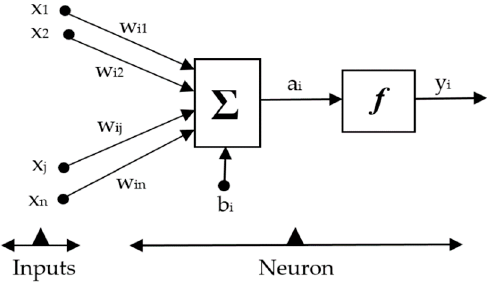
Figure 10. Math model of a neuron of FFANN.